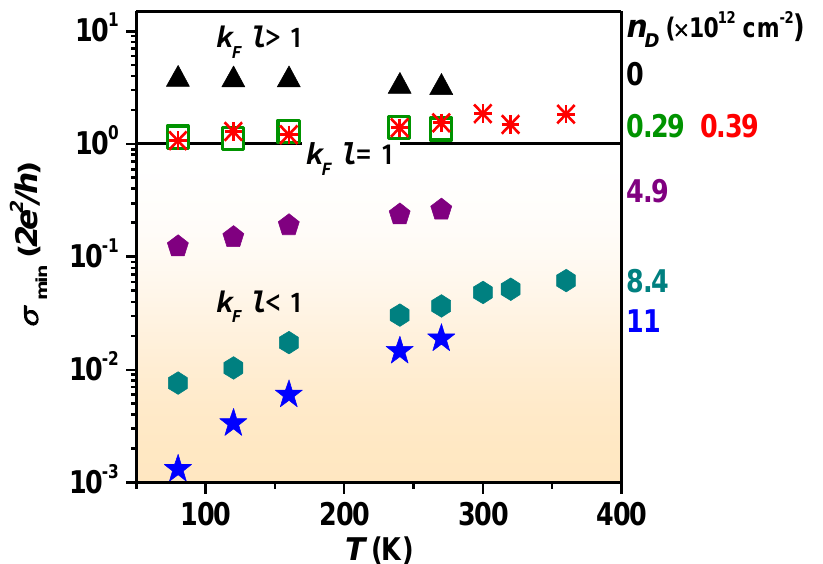
Figure 4. Temperature dependence of conductivity minimum for graphene oxides with different n D . Solid line indicates k F l =